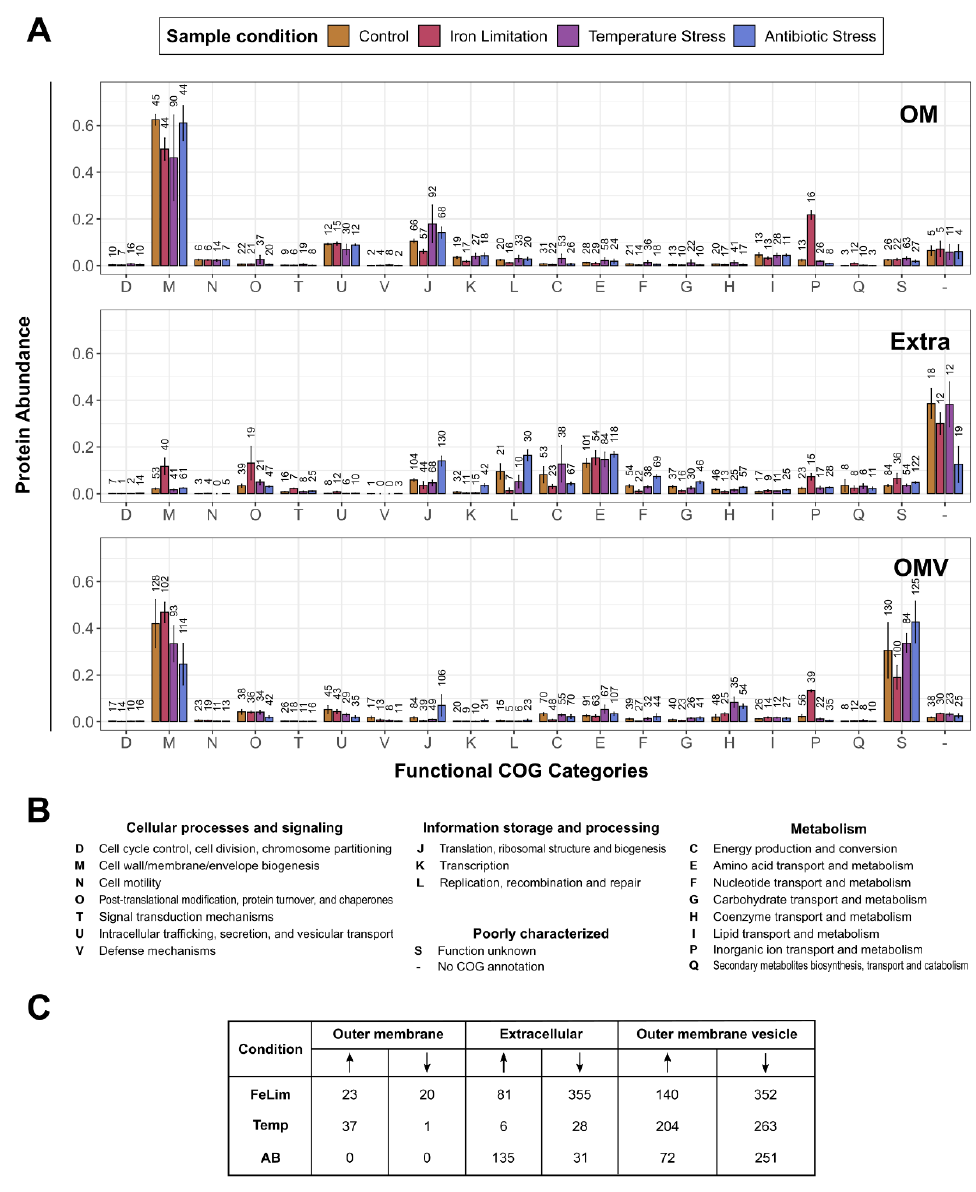
Figure 4. Overview of the functional protein compositions in the enriched outer membrane, extracellular, and outer membrane vesicle fractions. ( A ) Quantified proteins were grouped into functional categories that were predicted by eggNOG (description of the one-letter code in ( B )). The protein abundances of each bin were normalized to the total protein abundances in the enriched fraction and condition. The distributions within the conditions in the enriched outer membrane (OM), extracellular (Extra), and outer membrane vesicle (OMV) fractions were plotted. The number of quantified proteins within the conditions is indicated above the bars. Error bars indicate standard deviations between replicates ( n = 4). ( B ) COG one-letter code descriptions. ( C ) The number of proteins with significantly changed abundance. Arrow pointing up: significantly upregulated; Arrow pointing down: significantly downregulated. Detailed data are available in Table